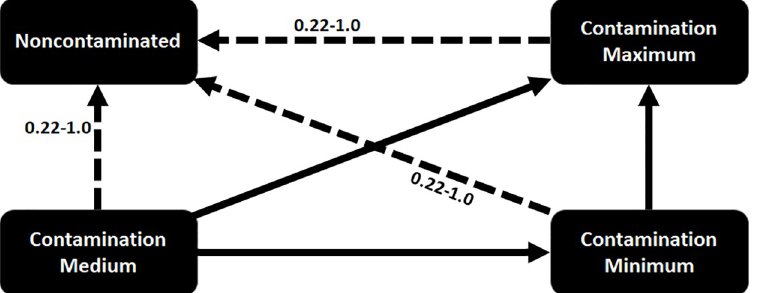
Fig 3. Fomite contamination model for C. difficile . Each state in the finite state machine shown above indicates the stages in the contamination/decay process. The solid arrows indicate possible transition in state. The transition between the states depend on number of infected people in the location. The dashed arrows represent transition assuming